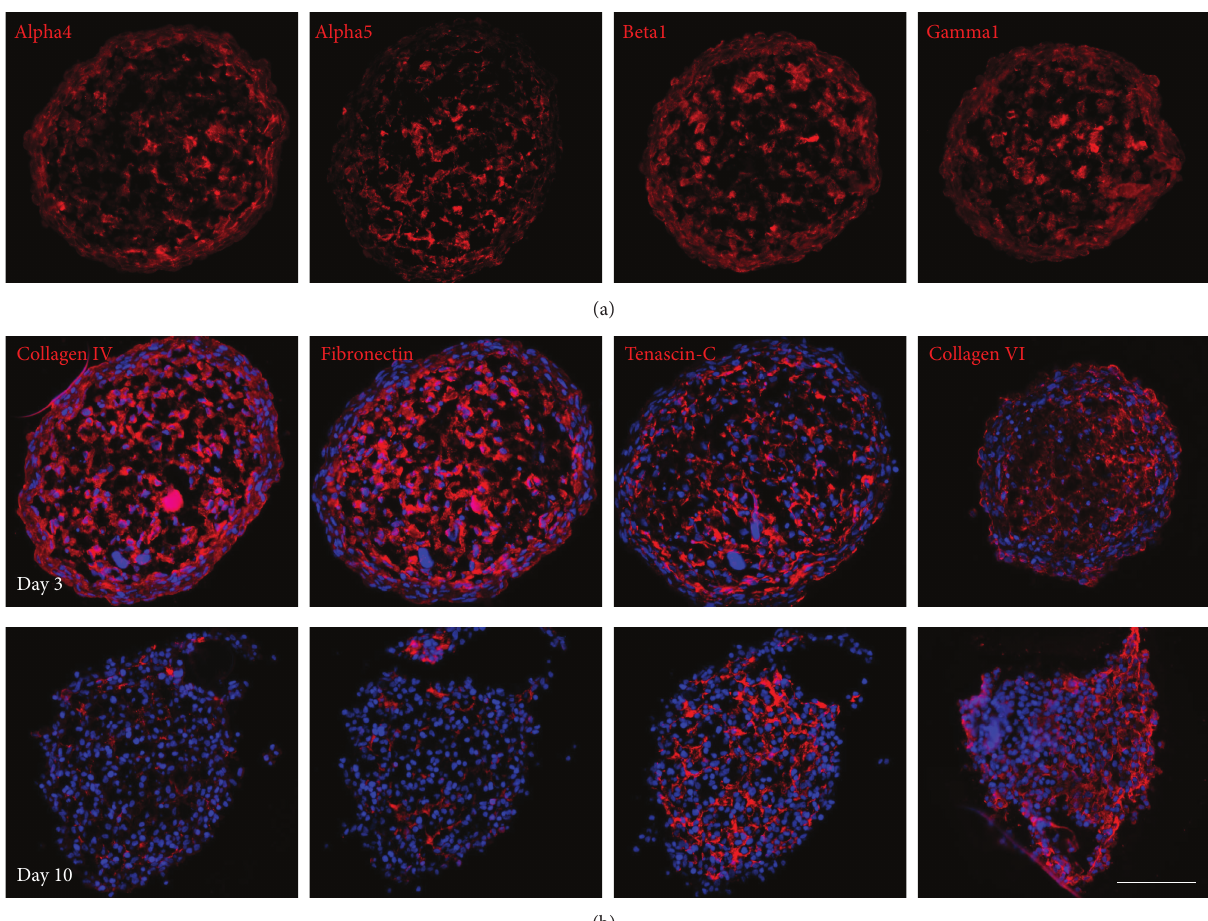
Figure 4: MSC spheroids express ECM components of the bone marrow. (a) The micrographs show immunofluorescence staining of 3- day-old MSC spheroid cryosections labeled with laminin chain-specific antibodies. Strong signals for the laminin alpha4, alpha5, beta1, and gamma1 chain were detected throughout the spheroids. (b) Sections from coculture spheroids harvested on days 3 and 10 were stained with antibodies against collagen type IV, fibronectin, tenascin-C, and collagen type VI. While all four matrix components were strongly expressed in early spheroids (upper panel), prominent expression was only detected for tenascin-C and collagen type VI in later stages of coculture (lower panel). Cell nuclei were counterstained with DAPI. Scale bar: 100 𝜇